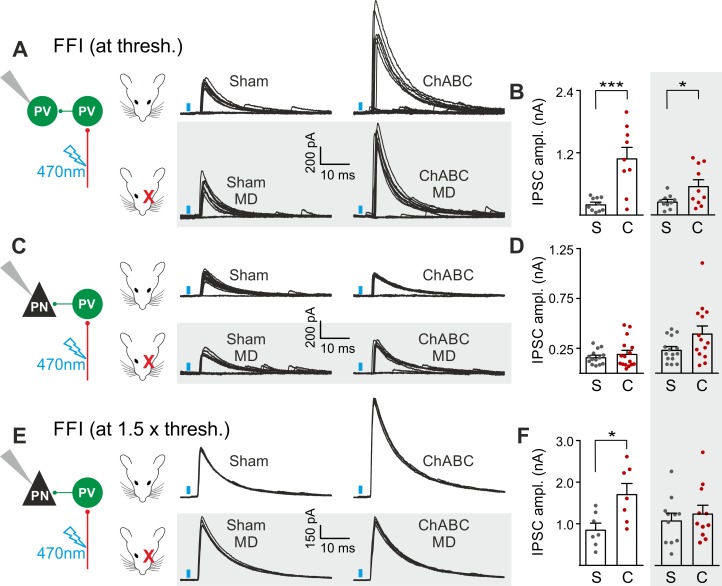
PNNs differently gate thalamocortical feed-forward inhibition on PV cells and PNs in a visually-dependent manner.(A) Example voltage-clamp traces of feed-forward inhibition (FFI) recorded in PV cells at threshold stimulation (note the presence of failures) in control (Sham, left) and ChABC-treated (ChABC, right) animals, in absence (top) and presence (bottom, shaded area) of MD. Neurons were voltage-clamped at the reversal potential for glutamate-mediated responses in order to isolate disynaptic inhibition. Vertical blue bars correspond to photostimulation. (B) Population data of feed-forward IPSC amplitudes in control (sham, grey) and ChABC-treated (ChABC, red) animals, in the absence (left) and presence (right, shaded area) of MD. (C–D) Same as in (A–B), but for PNs. (E–F) Same as in (C–D), but at 1.5 x threshold stimulation. *: p < 0.05; **: p < 0.01; ***: p < 0.001. All values are in Table S7.
10.7554/eLife.41520.020Figure 4—source data 1.Source data for Figure 4B,D,H,F.